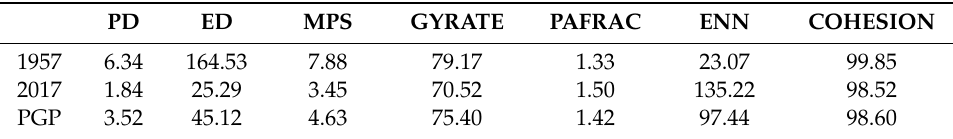
Table 4. Proposal improvements landscape configuration to enhance non-forest habitat suitability using PGP (Patch-Growing Process).